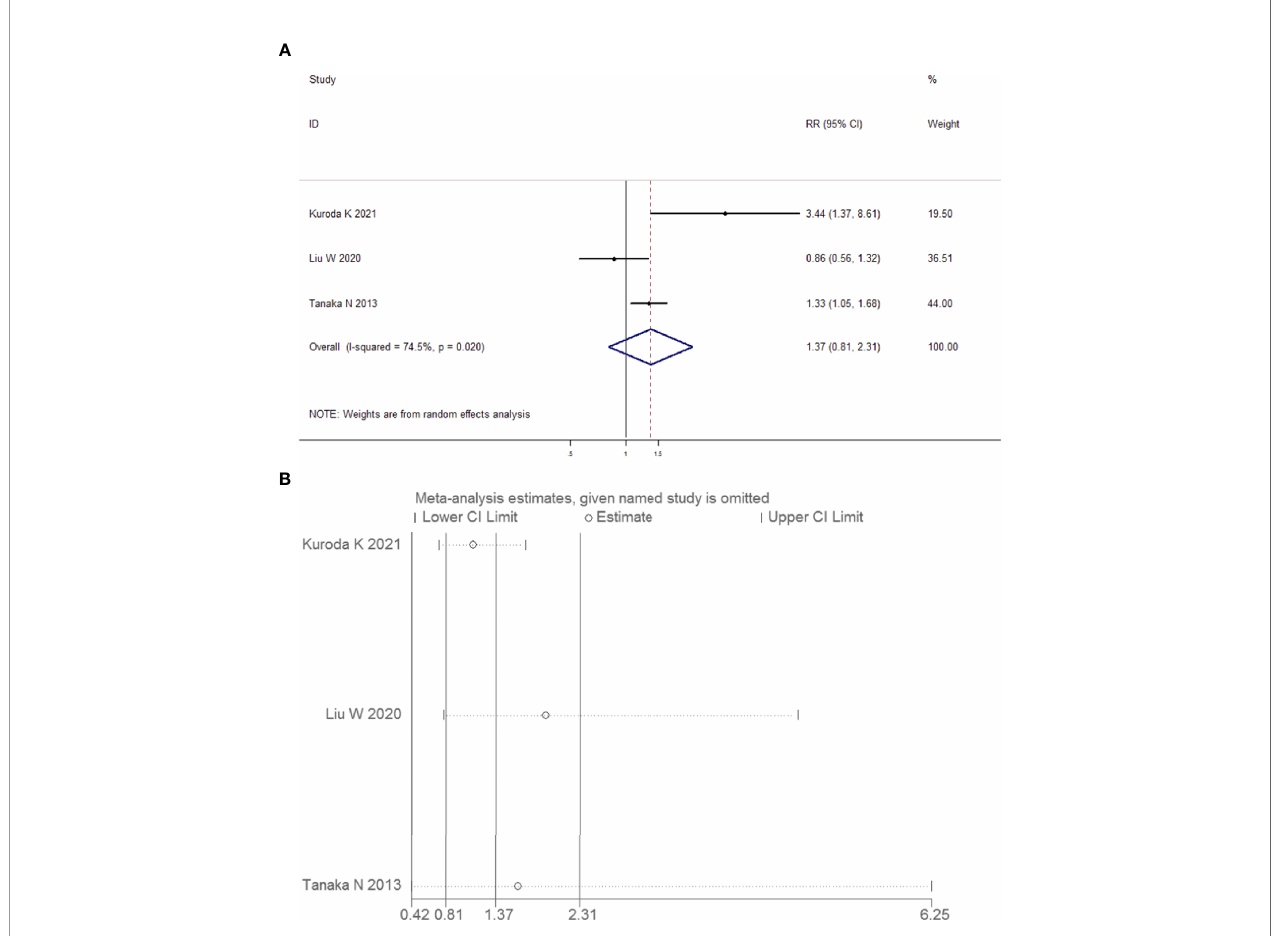
FIGURE 14 | Forest plots for the risk of lymphovascular-invasive UUT-UC in patients with preoperative positive urine cytology. (A) Meta-analysis. (B) Sensitivity